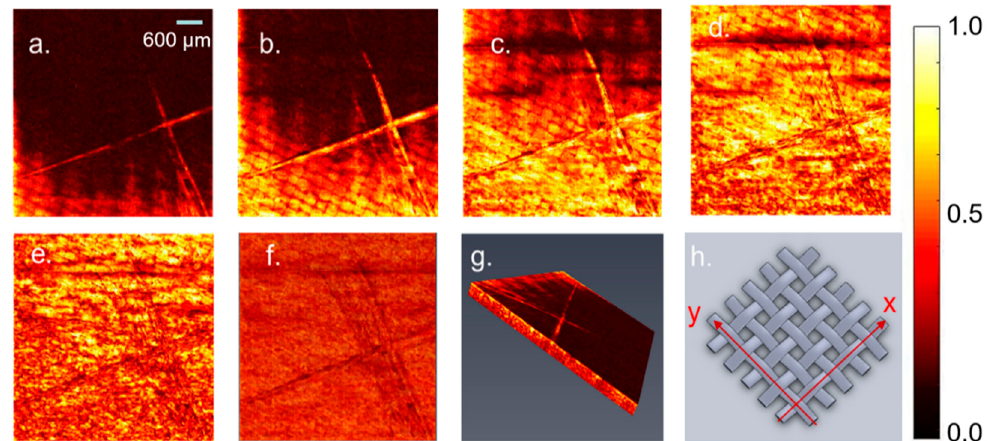
Figure 4. The 3D C-scan images of micro-scale damage in composites. ( a – e ) X-Y plane slices at a depth of 0.001, 0.025, 0.05, 0.065, and 0.15 mm, respectively. ( f ) The photoacoustic maximum-amplitude image projection (average) from the top of the carbon fiber-reinforced plastic (CFRP) composites. ( g ) A 3D C-scan image of a rotating 3D model. ( h ) Grid pattern explanation image.